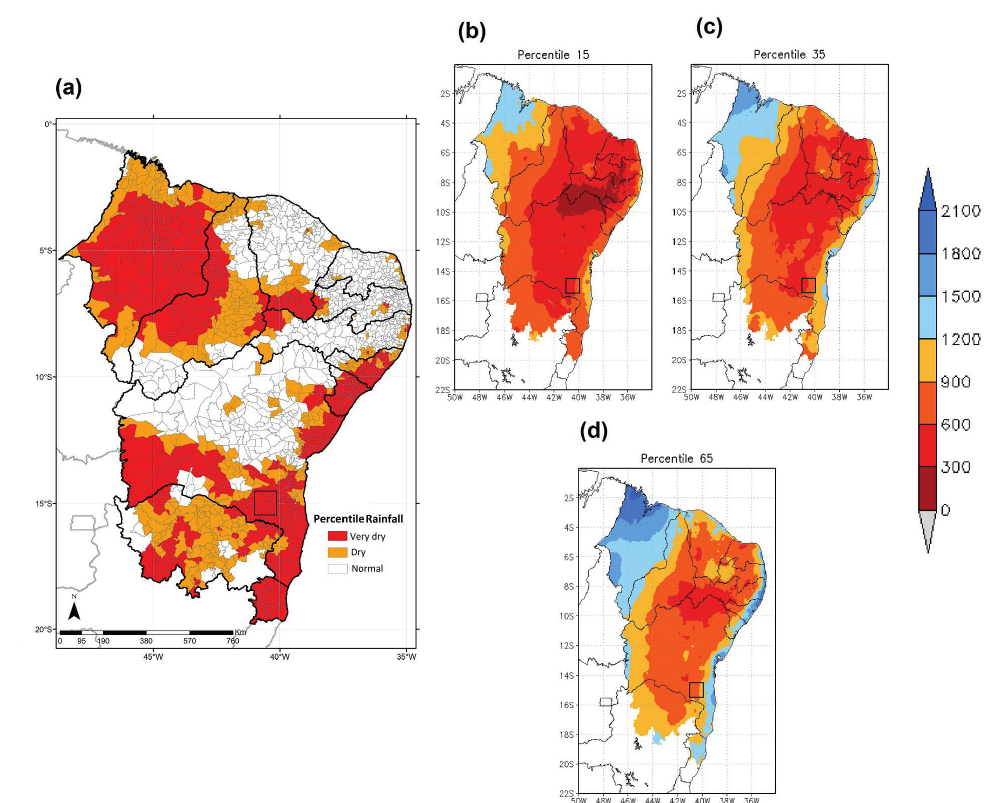
Figure 3 - Classification of the drought condition according to the percentile of precipitation from October 2015 to September 2016: ( a ) and accumulated rainfall (mm) for thresholds Percentile 15% ( b ) Percentile 35% ( c ) and Percentile 65% ( d